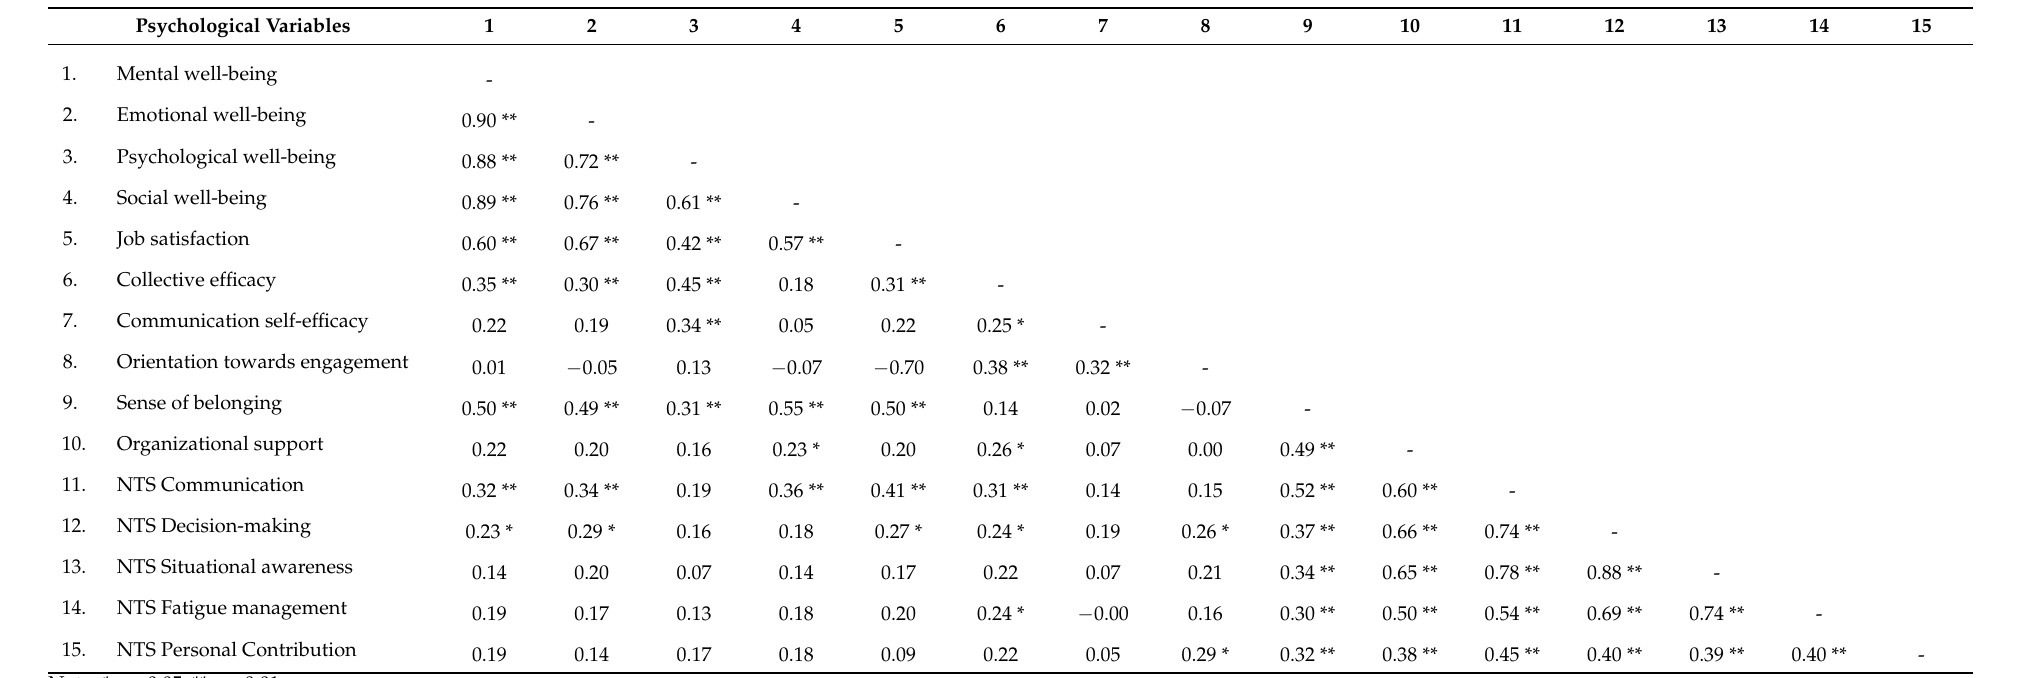
Table 2. Correlations among the psychological